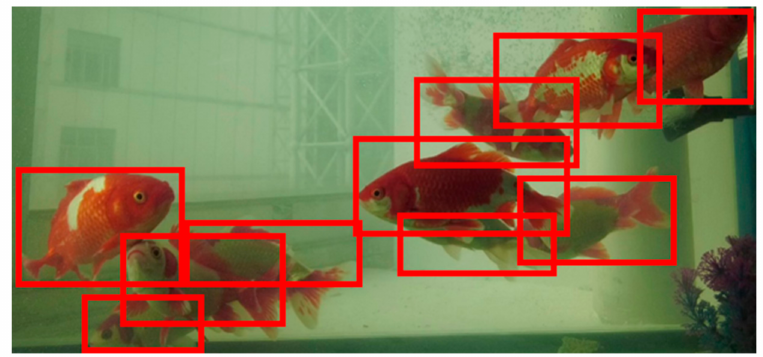
Figure 7. Multi-level frame